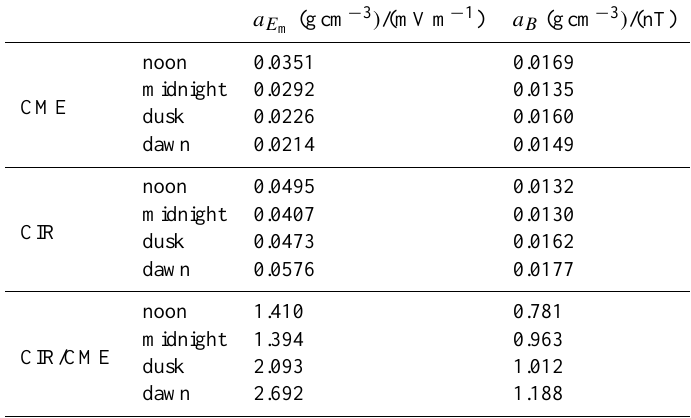
and a B , at different local time sectors for CME and CIR storms and their m